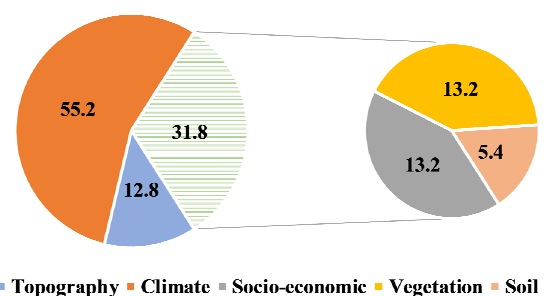
Figure 21. Variable importance analysis as a percentage based on the RF model.